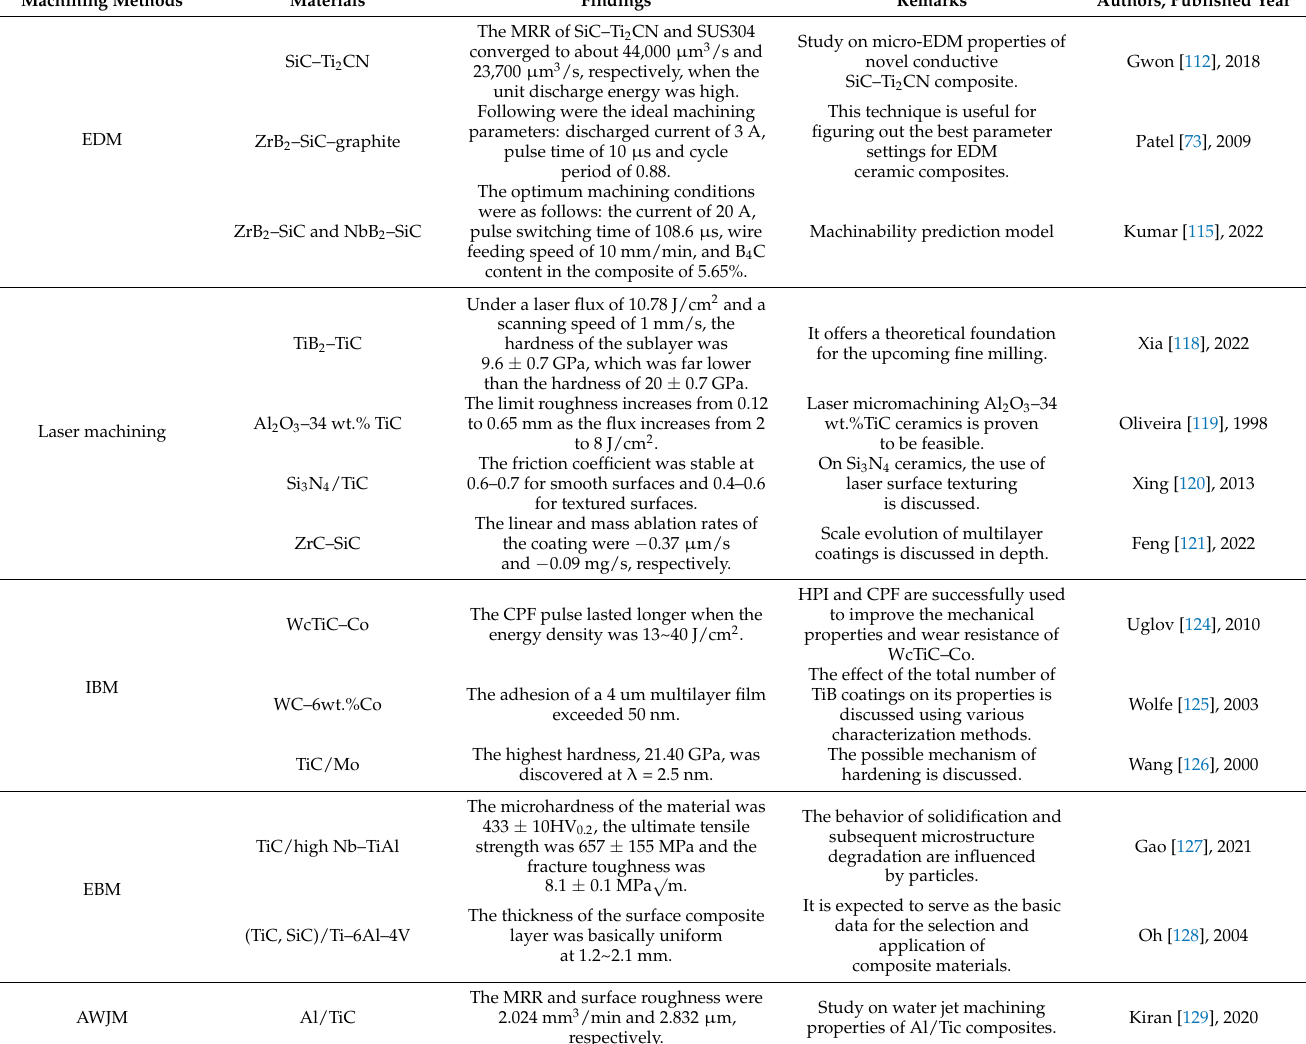
Table 2. Summary of nontraditional machining of carbide-based